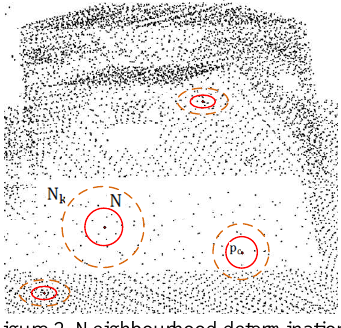
Figure 2. Neighbourhood